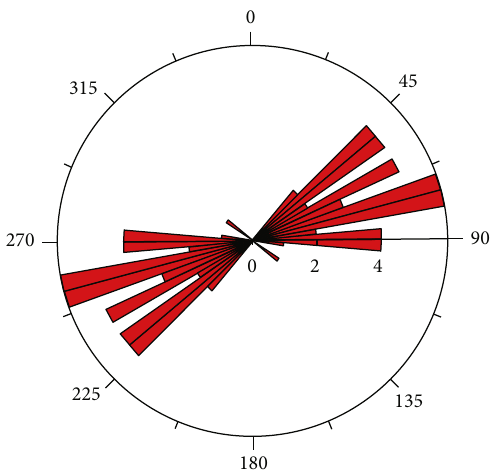
Figure 1: Statistics of fracture orientation observed in Chang 6